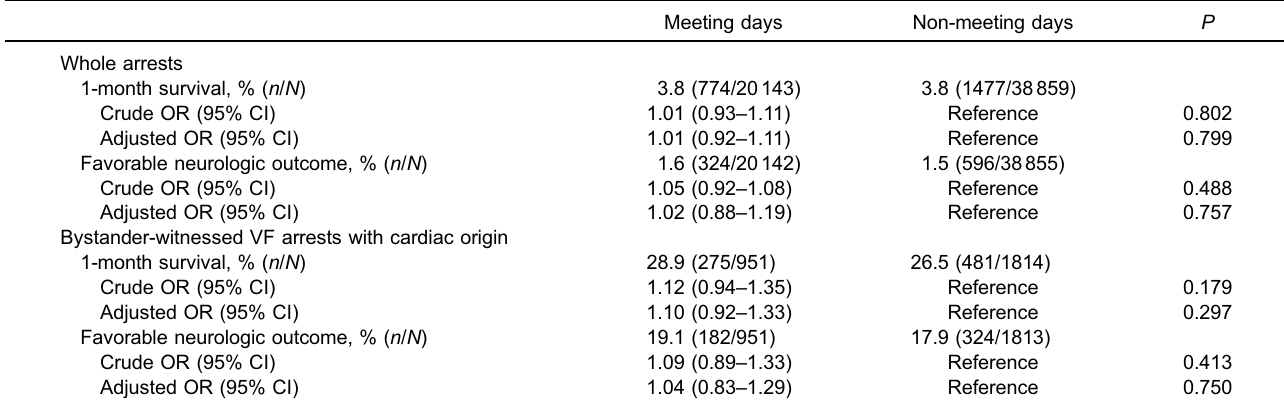
Table 2. Outcomes of out-of-hospital cardiac arrest during meeting and non-meeting